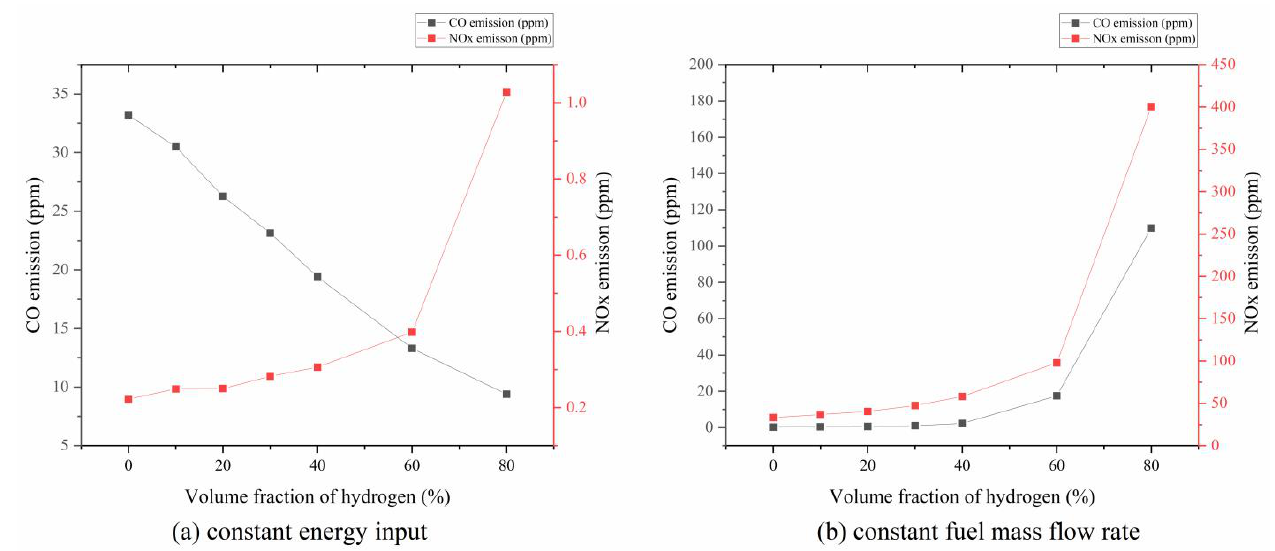
Figure 12. Emission characteristics for hydrogen-methane fuels. ( a ) constant energy input; ( b ) constant fuel mass flow